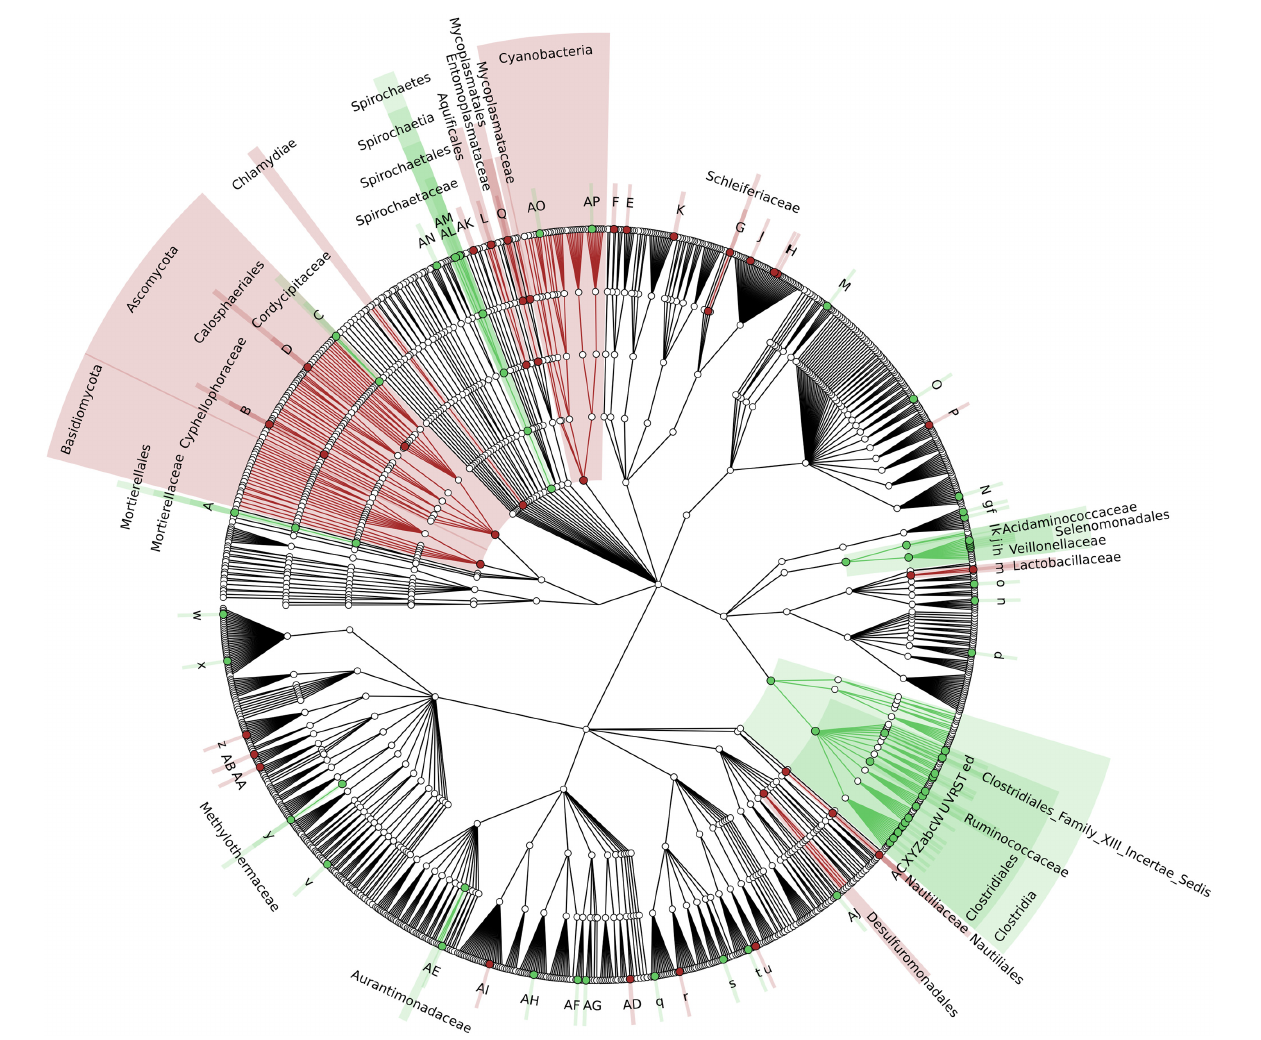
FIGURE 2 | Cladogram illustrating the distribution of taxa with differential abundance between CCs and feces, according to S-MG data. Each dot represents an identified taxon, with taxa higher in CCs colored in green, and those higher in feces in brown. Abbreviations: A, Mortierella ; a, Lachnoclostridium ; AA, Zymobacter ; AB, Marinomonas ; AC, Lebetimonas ; AD, Candidatus Pelagibacter ; AE, Microvirga ; AF, Wolbachia ; AG, Candidatus Paracaedibacter ; AH, Magnetospira ; AI, Haematobacter ; AJ, Chondromyces ; AK, Thermoanaerobaculum ; AL, Treponema ; AM, Brachyspira ; AN, Cloacibacillus ; AO, Mastigocoleus ; AP, Acaryochloris ; B, Cyphellophora ; b, Youngiibacter ; C, Beauveria ; c, Clostridium ; d, Oscillibacter ; D, Togninia ; e, Anaerovorax ; E, Segetibacter ; f, Dielma ; F, Phaeodactylibacter ; g, Faecalitalea ; G, Schleiferia ; H, Algibacter ; h, Mitsuokella ; I, Psychroserpens ; i, Selenomonas ; J, Cellulophaga ; j, Sporomusa ; K, Flexibacter ; k, Megasphaera ; l, Megamonas ; L, Persephonella ; m, Lactobacillus ; M, Olsenella ; n, Alkalibacterium ; N, Pseudonocardia ; o, Eremococcus ; O, Microbispora ; P, Dactylosporangium ; p, Saccharibacillus ; q, Acidovorax ; Q, Mycoplasma ; r, Azohydromonas ; R, Flavonifractor ; S, Intestinimonas ; s, Thiomonas ; t, Chitiniphilus ; T, Epulopiscium ; u, Conchiformibius ; U, Ruminococcus ; v, Anaerobiospirillum ; V, Anaerotruncus ; w, Budvicia ; W, Dehalobacter ; X, Lachnospira ; x, Raoultella ; Y, Butyrivibrio ; y, Methylohalobius ; z, Lysobacter ; Z, Shuttleworthia